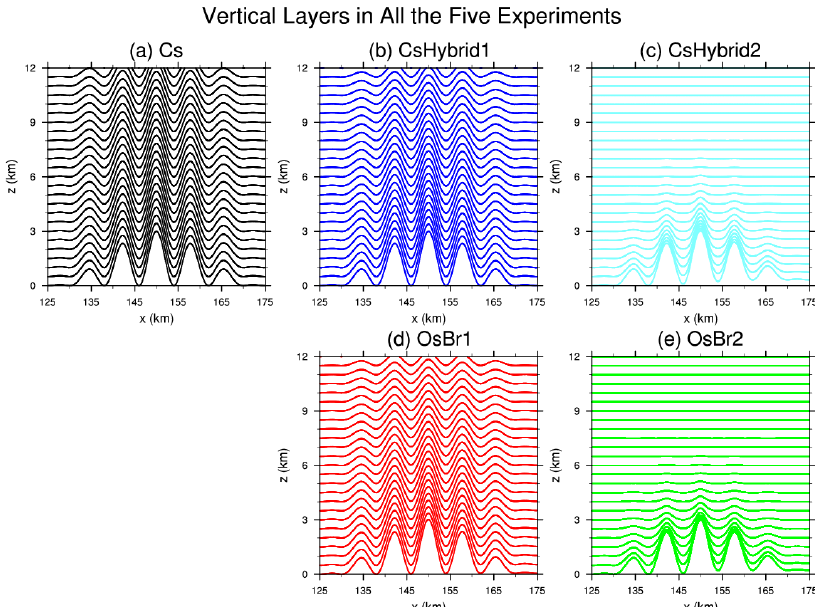
Figure 7. Vertical levels in all the five experiments. The upper three figures are the vertical levels in the CS coordinate, and the two kinds of hybrid σ coordinate; the lower two are those in the OS coordinate. Specifically, the black, blue, sky-blue, red and green curves represent the vertical levels in Cs, CsHybrid1, CsHybrid2, OsBr1 and OsBr2